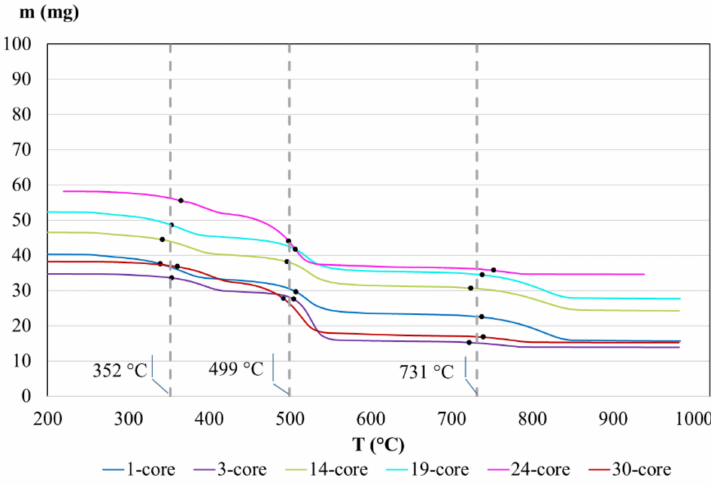
Figure 5. TGA curves of core insulations of tested cables.